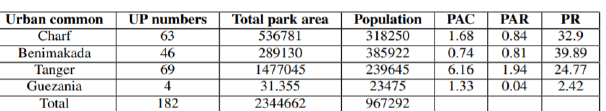
Table 2 . Up Numbers And Indices (Park Area Per Capita, Pac (in m²), Park Area Ratio, Par (In \%), Population Ratio, Pr (in \%)) For The Four Commons; Tanger, Boukhalef, Charf And Benimakada. (Situation 2021)